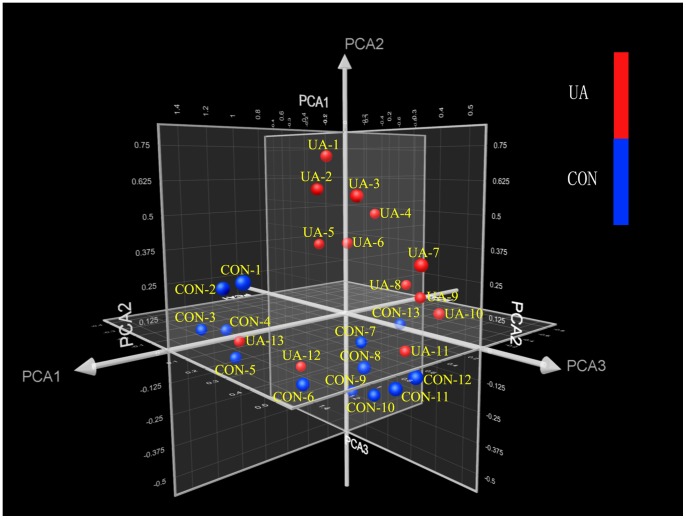
Principle component analysis (PCA) of circulating miRNA profiling in the derivation cohort.The miRNA expression profile was reduced to three main principal components. PCA showed that most UA cases (84.6%, 11/13) could be correctly classified from the control group (CON).